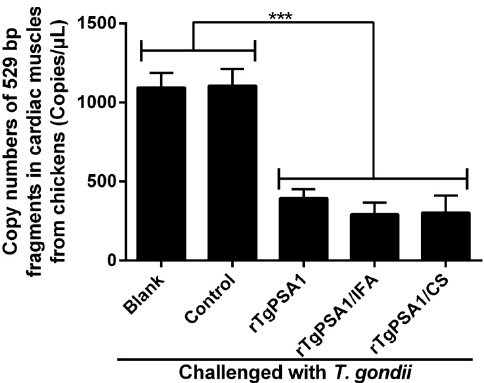
Figure 11. Coefficient of growth in chickens. Ten chickens were weighed at different sampling times. Results were assessed by one-way ANOVA followed by Dunnett’s test, and values are shown as mean ± SD (n = 10). Values between rTgPSA1/IFA and rTgPSA1/CS groups were com- pared with the independent t -test. * p < 0.05 and *** p < 0.001 compared with blank or control group.